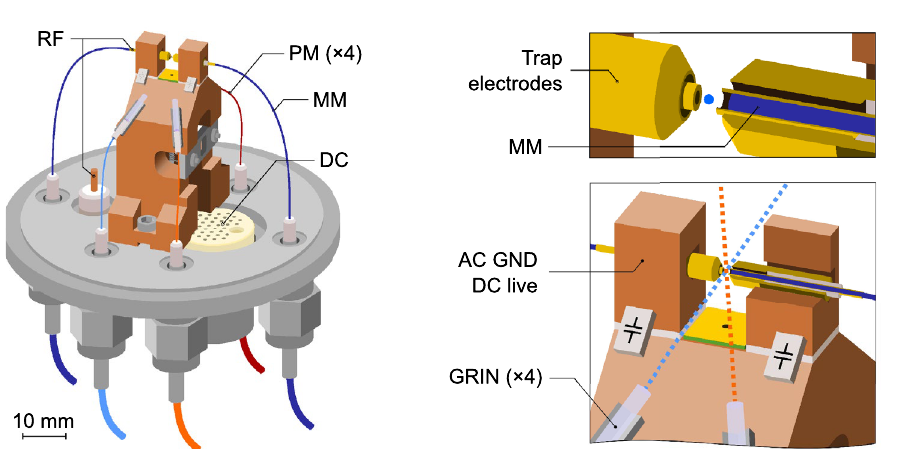
Figure 2. Schematic representation of the fiber-integrated ion trap. Temperature sensors, wiring and dc electrodes have been omitted. Left: overview of the trap showing the polarisation maintaining (PM) fibers used for light delivery and the multi-mode (MM) fiber used for fluorescence collection, as well as the fiber, dc and rf feedthroughs. Bottom right: zoom-in on the trapping structure showing the gradient-index (GRIN) lens collimators and the path followed by the delivery beams, as well as the rf decoupling capacitors. Top right: zoom-in and cross-section of the electrode structure, showing the MM fiber embedded inside the rf electrode. The position of the ion is represented with a light blue circle (not to